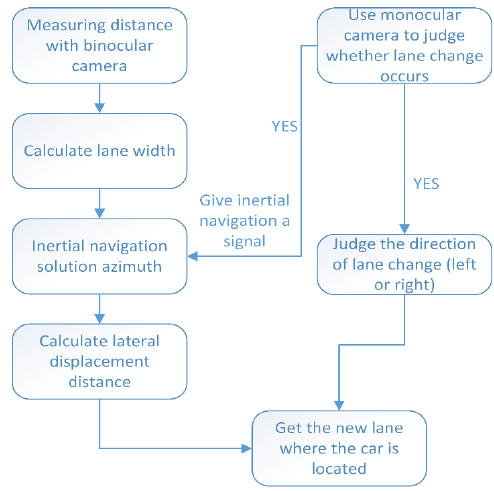
Figure 1. Vehicle lateral positioning system.